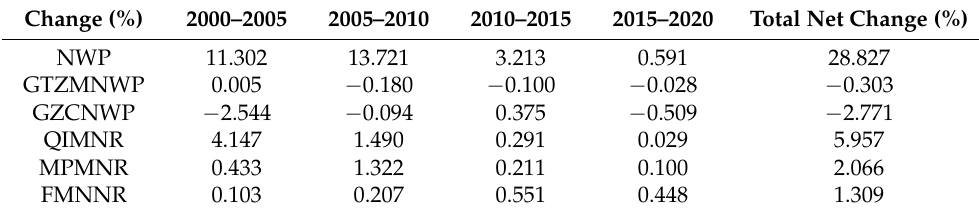
Table 5. The Proportion of Mangrove Changing Pixels in Each Nature